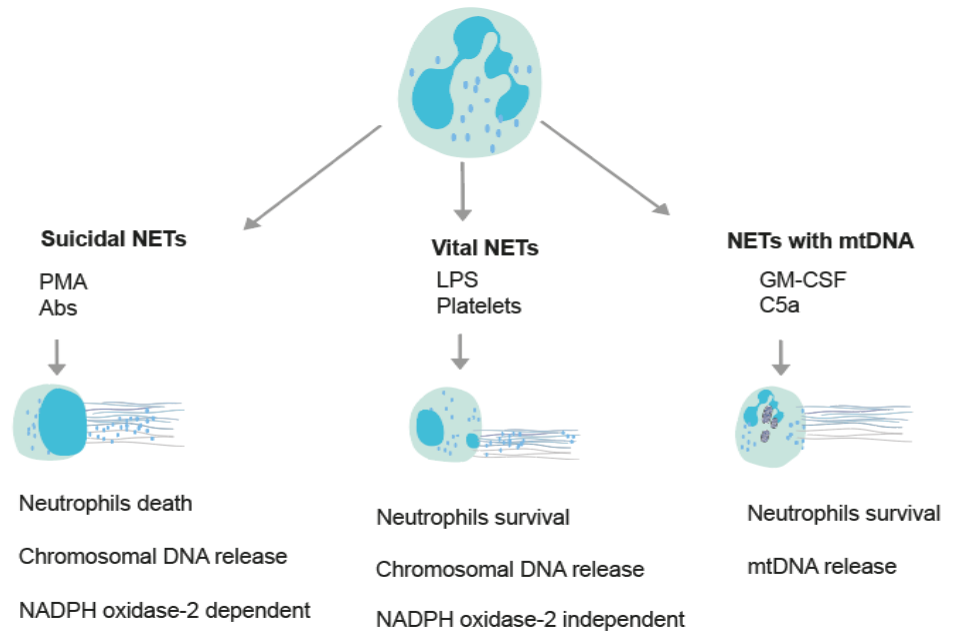
Figure 1. Schematic diagram demonstrating the different types of NETs. Depending on the stim- ulation, various molecular pathways result in the generation of NETs. This diagram presents the fundamental pathways of NET production, and in particular, the vital NETs or NADPH oxidase-2 (NOX) -independent pathway and the suicidal NETs or NADPH oxidase-2 (NOX) -dependent path- way. Furthermore, NETs can also consist of mitochondrial DNA (mtDNA) rather than chromosomal DNA. In this pathway, intracellular grey structures represent mitochondrial organelles. Some indica- tive NET inducers are chemical compounds or inflammatory agents (Phorbol-12-myristate-13-acetate (PMA), antibodies (Abs), lipopolysaccharides (LPS), activated platelets, granulocyte-macrophage colony-stimulating factor (GM-CSF) and complement component C5a).